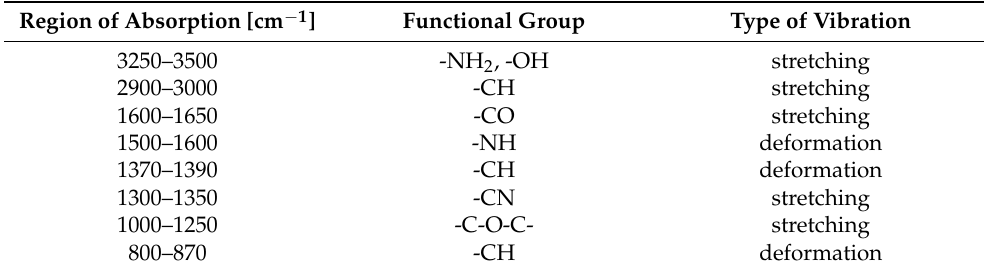
Table 3. Vibrations of specific bonds in the analyzed materials.